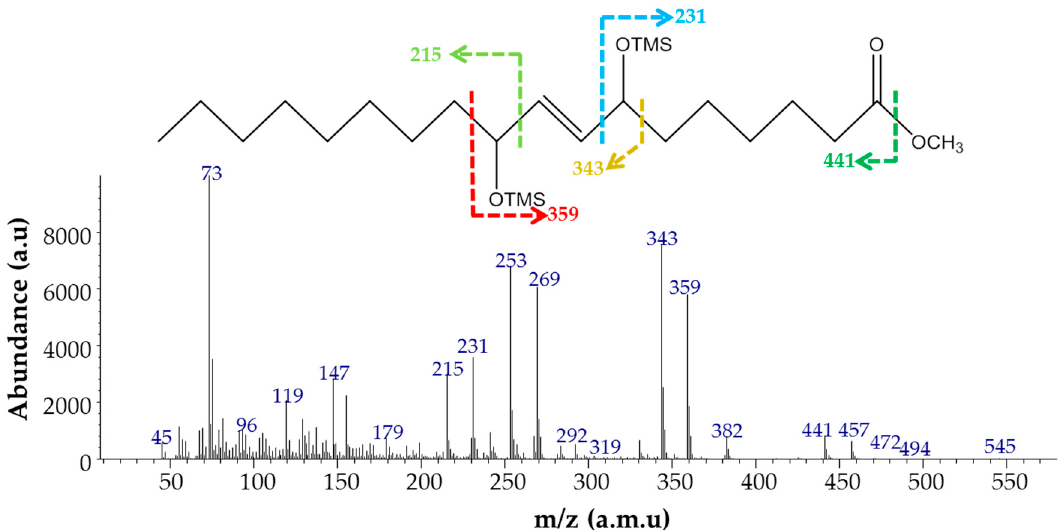
Figure 2. EI mass spectra of the major product produced from olive oil by Pseudomonas aeruginosa PR3.